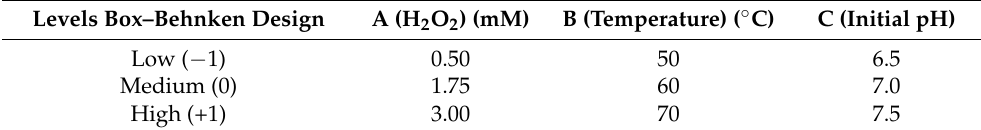
Table 6. Experimental design levels with three